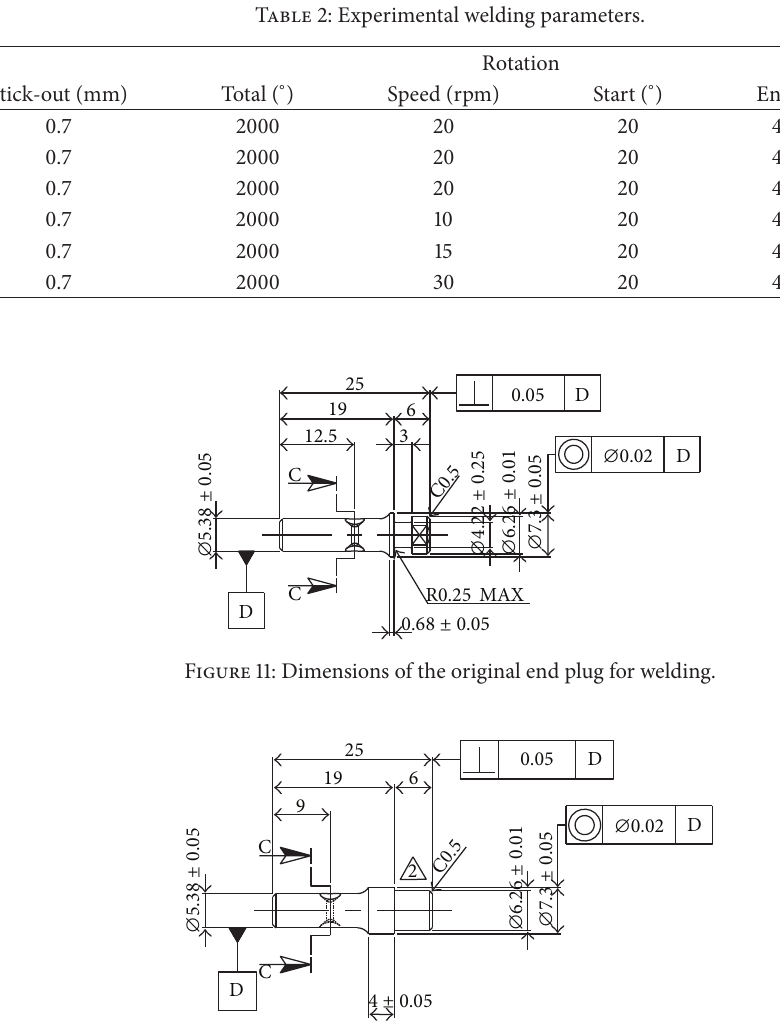
Figure 12: Dimensions of the improved end plug for welding.